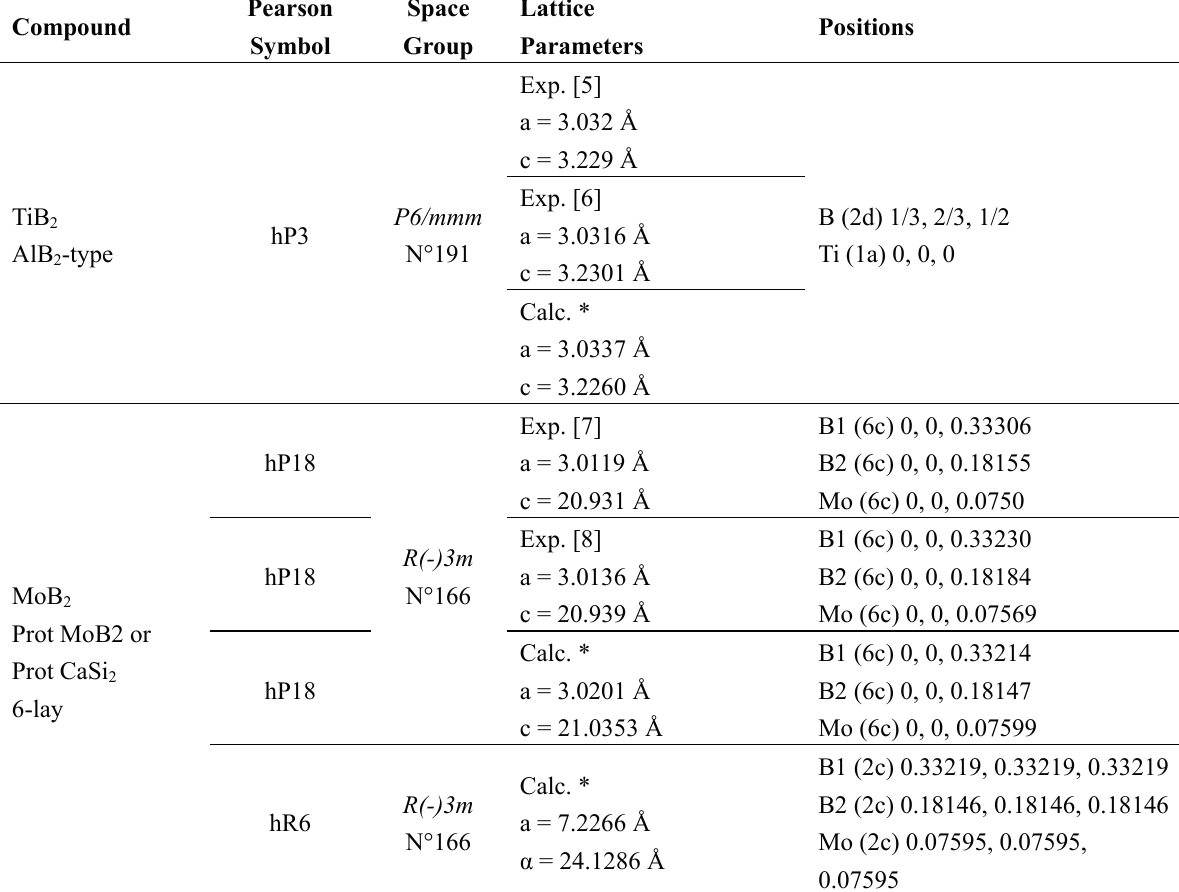
Table 1. Structures of the diborides considered in the present work